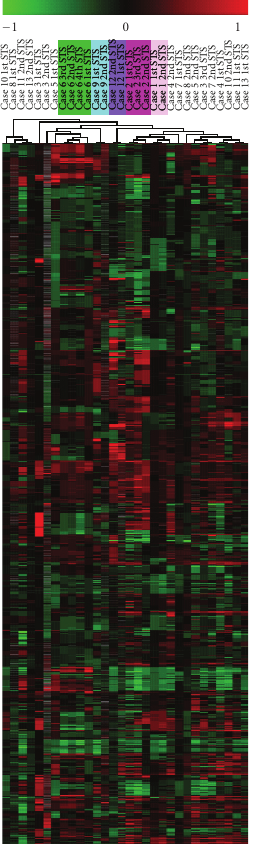
Figure 1: Unsupervised hierarchical cluster analysis of all 30 soft tissue sarcomas from 13 patients. The analysis was based on the ∼ 17000 clones that survived the preprocessing filters, and close clustering of the metachronous STS was demonstrated in 5 patients (case 1, 2, 6, 9, and 12 marked with di ff erent colours), whereas the STS from the remaining 8 patients were scatter in the analysis. Clustering was done using the TMeV application from the TM 4 microarray software